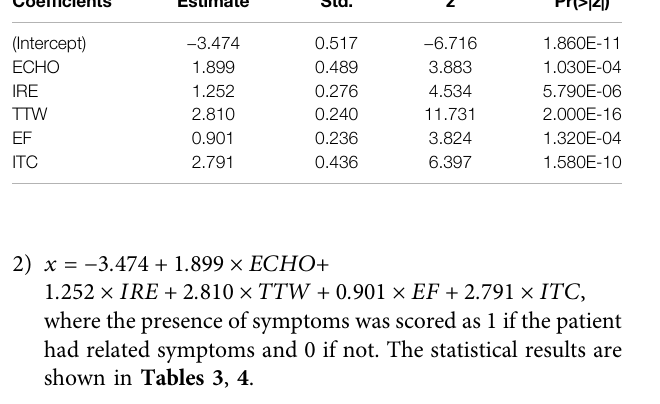
TABLE 4 | Results of the logistic regression analysis to determine the association between ultrasound characteristics and PTC malignancy. Coef fi cients Estimate